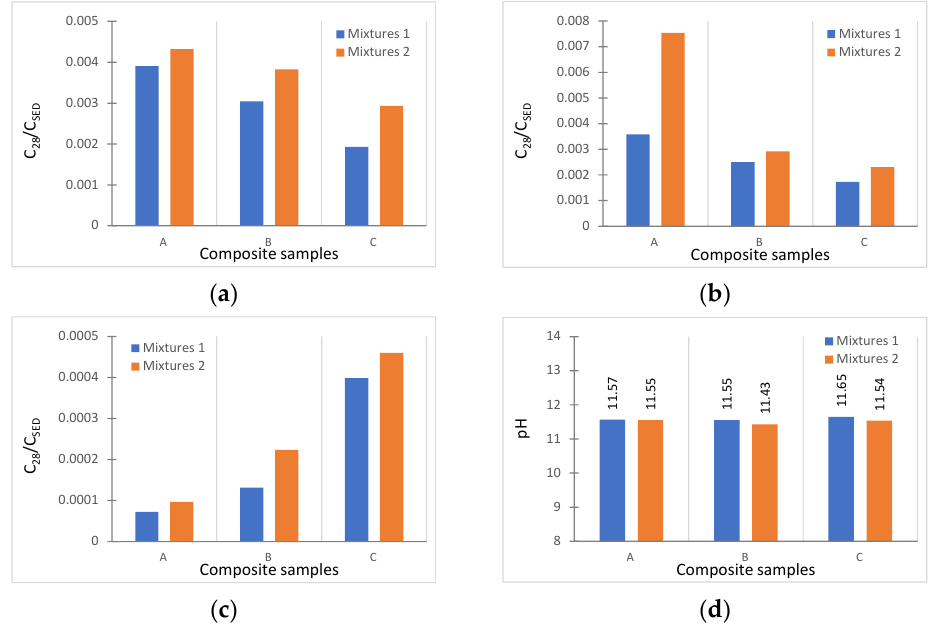
Figure 6. Rates of leaching of metals (C 28 /C SED ) for As ( a ), Cu ( b ), and Zn ( c ); and pH trend ( d ).